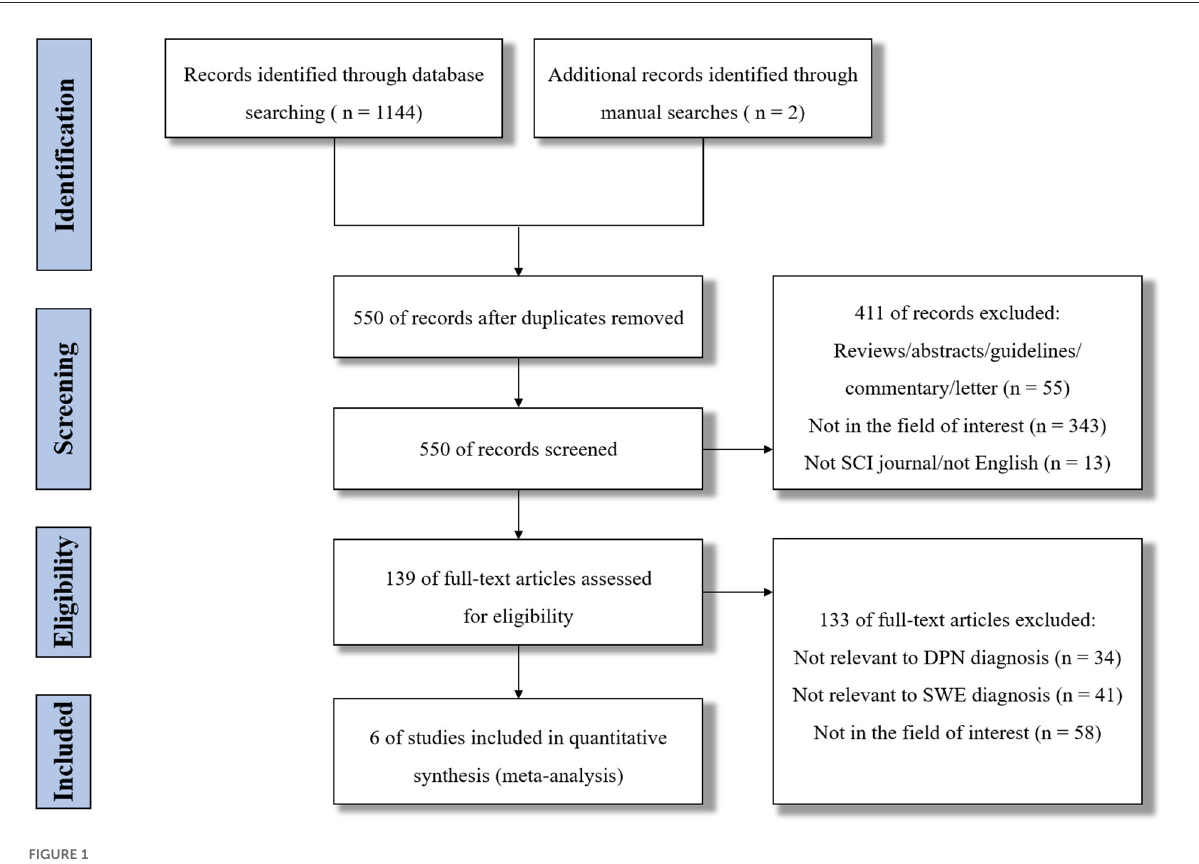
FIGURE1 Flow diagram of study